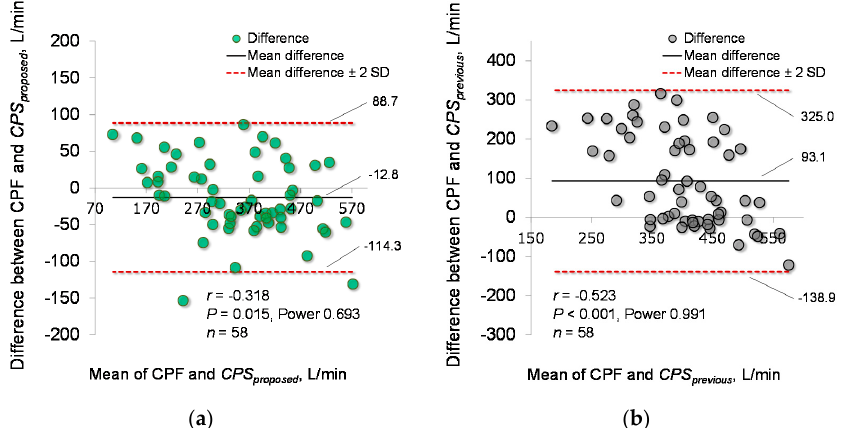
Figure 6. Bland-Altman plots of the measured and estimated CPFs. ( a ) The estimation accuracy of the proposed model ( CPS proposed ). ( b ) The estimation accuracy of the previous model ( CPS previous ). The horizontal line is the mean of the measured CPF and estimated cough peak flow ( CPS X ). The vertical line represents the difference between the measured CPF and CPS X . The bold black solid lines represent the mean differences between the CPF and CPS X , and the red dotted lines represent the mean differences ± 2 standard